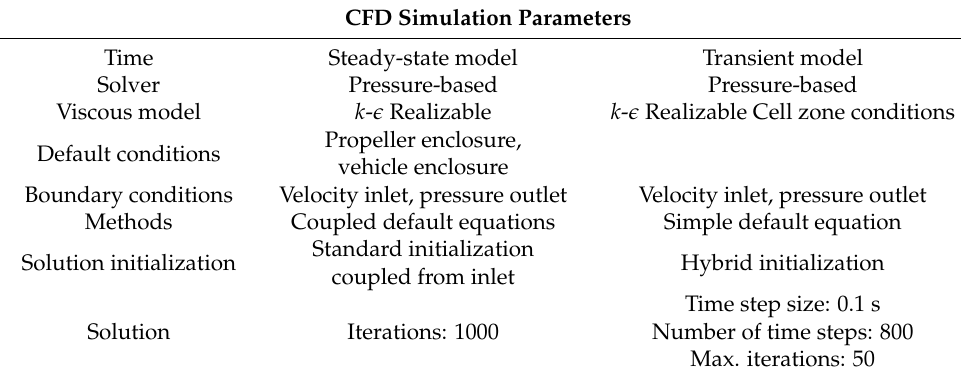
Table 2. CFD parameters for MCR UAV v3.0 analysis.